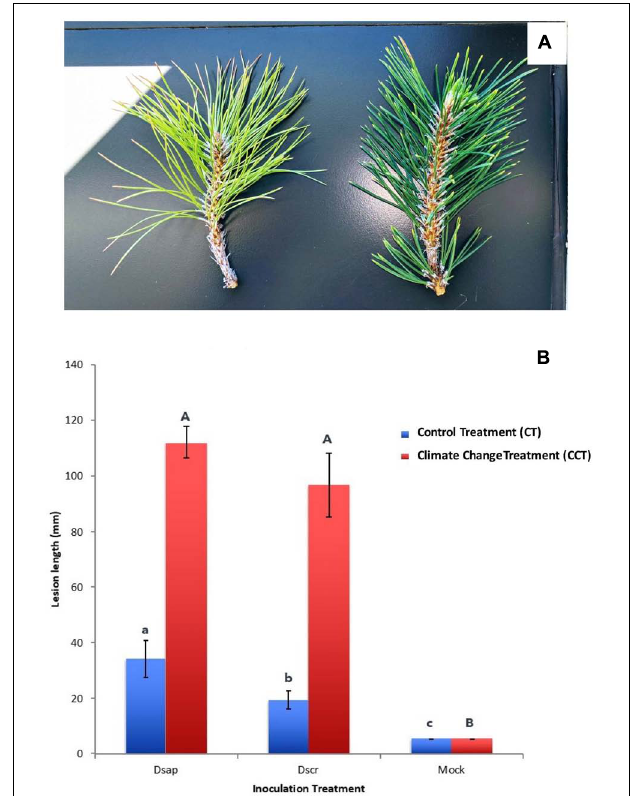
FIGURE 2 | (A) Chlorotic and partly desiccated appearance of pine needles subjected to climate change treatment (left) vs. deep green and turgid needles in the control treatment (right). (B) Lesion lengths (mm) measured 3 weeks post inoculation. X -axis: Dsap, inoculation with D. sapinea ; Dscr, inoculation with D. scrobiculata . Blue bars represent the control climate treatment (CT), red bars the climate change treatment (CCT). Error bars: standard error of the mean. Different letters represent significant differences within climate treatment (lower case letters for CT, upper case letters for CCT). CCT: t 6 = 3.078, p = 0.015; CT: t 8 = 1.189, p =